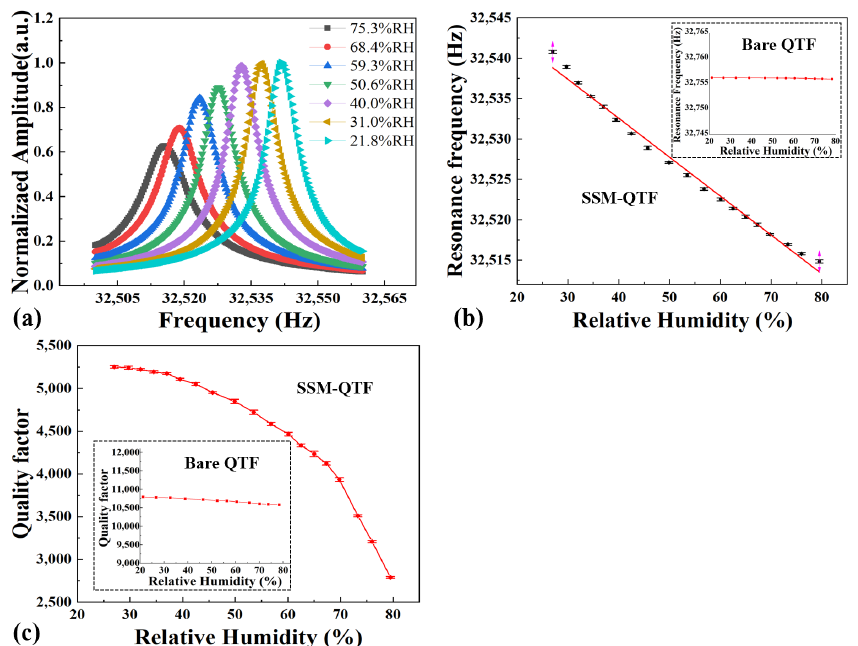
Figure 4. ( a ) Resonance curves of the SSM-QTF at different humidities. ( b ) Frequency variations of an SSM-QTF as a function of humidity. The figure inset shows the resonance frequency variations of a bare QTF. ( c ) Q factor variations of an SSM-QTF as a function of humidity. The figure inset shows the resonance frequency variations of a bare QTF.